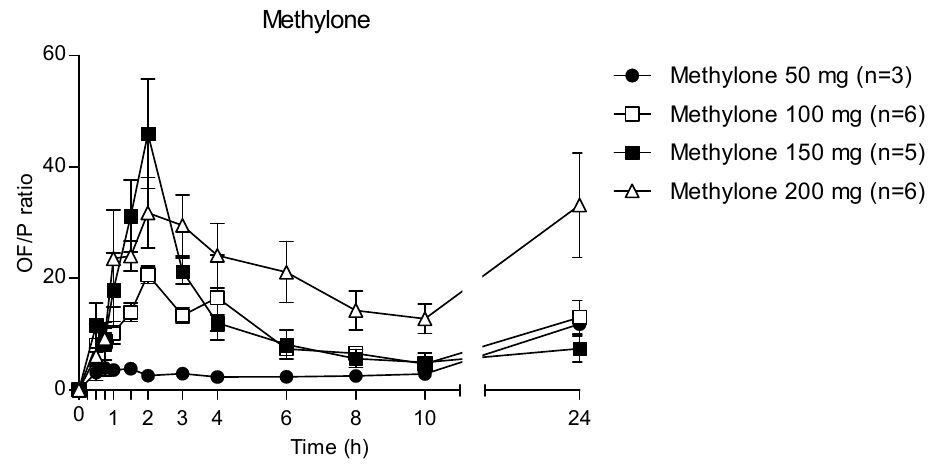
Figure 7. Time pro fi le of methylone OF/P ratio. Figure 7. Time profile of methylone OF/P